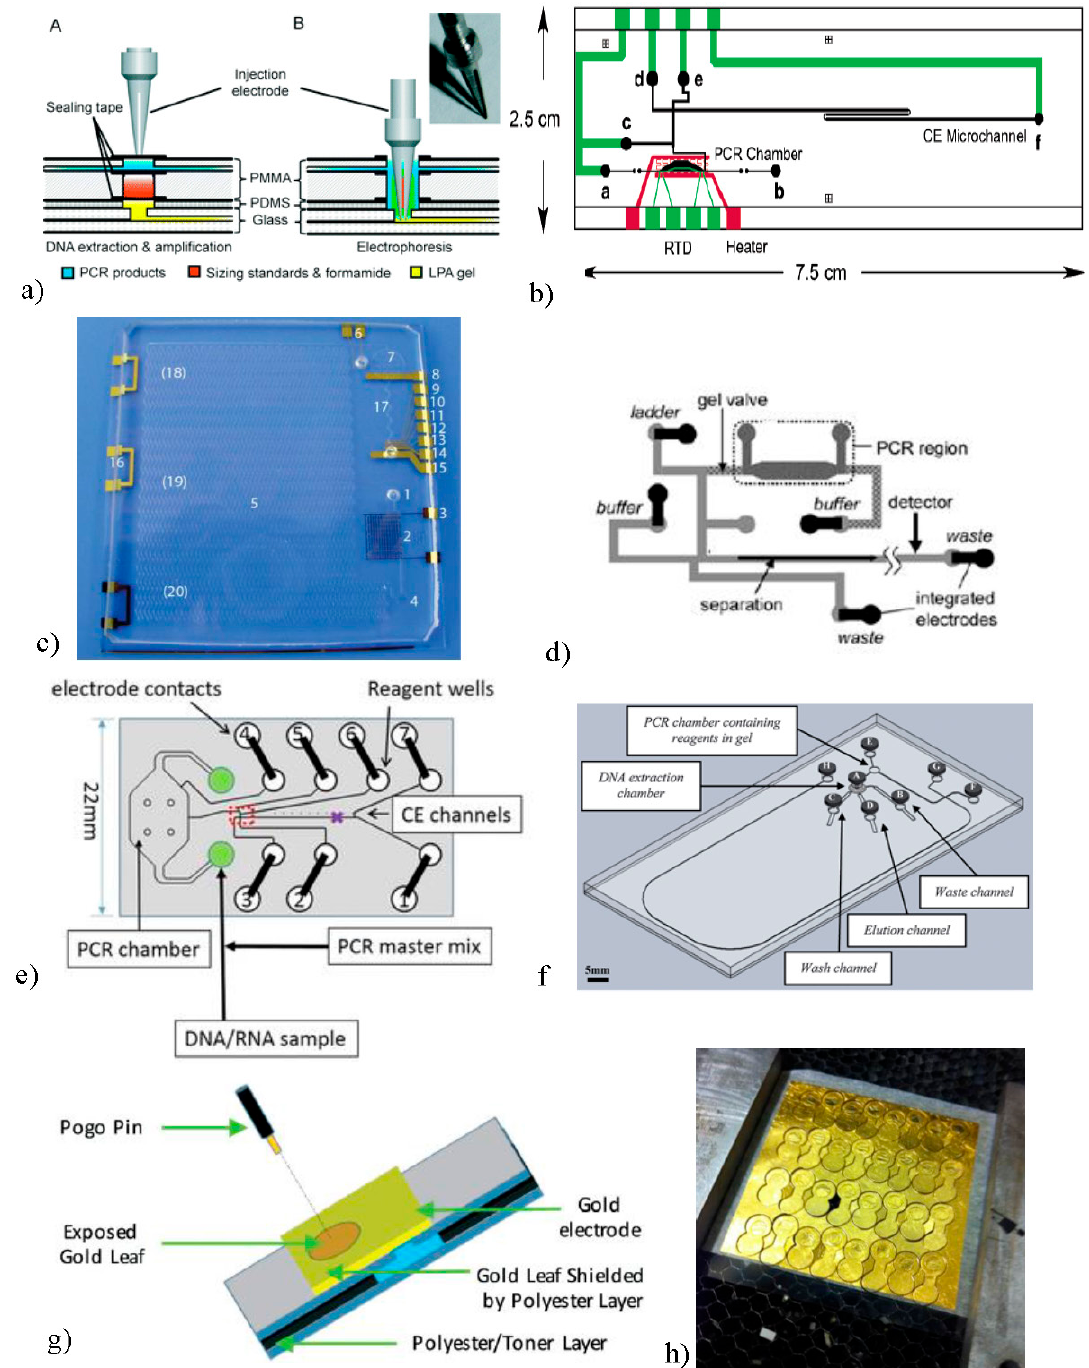
Figure 1. Integrated electrode examples. ( a ) Reproduced with permission from [36]; published by Royal Society of Chemistry, 2016. ( b ) Reprinted with permission from [49]; published by American Chemical Society, 2004. ( c ) Reproduced with permission from [52]; published by Royal Society of Chemistry, 2012. ( d ) Reproduced with permission from [54]; published by American Chemical Society, 2003. ( e ) Reproduced with permission from [55]; published by Wiley, 2016. ( f ) Reproduced with permission from [56]; published by Royal Society of Chemistry, 2011. ( g , h ) Reproduced with permission from [25]; published by Royal Society of Chemistry, 2016.